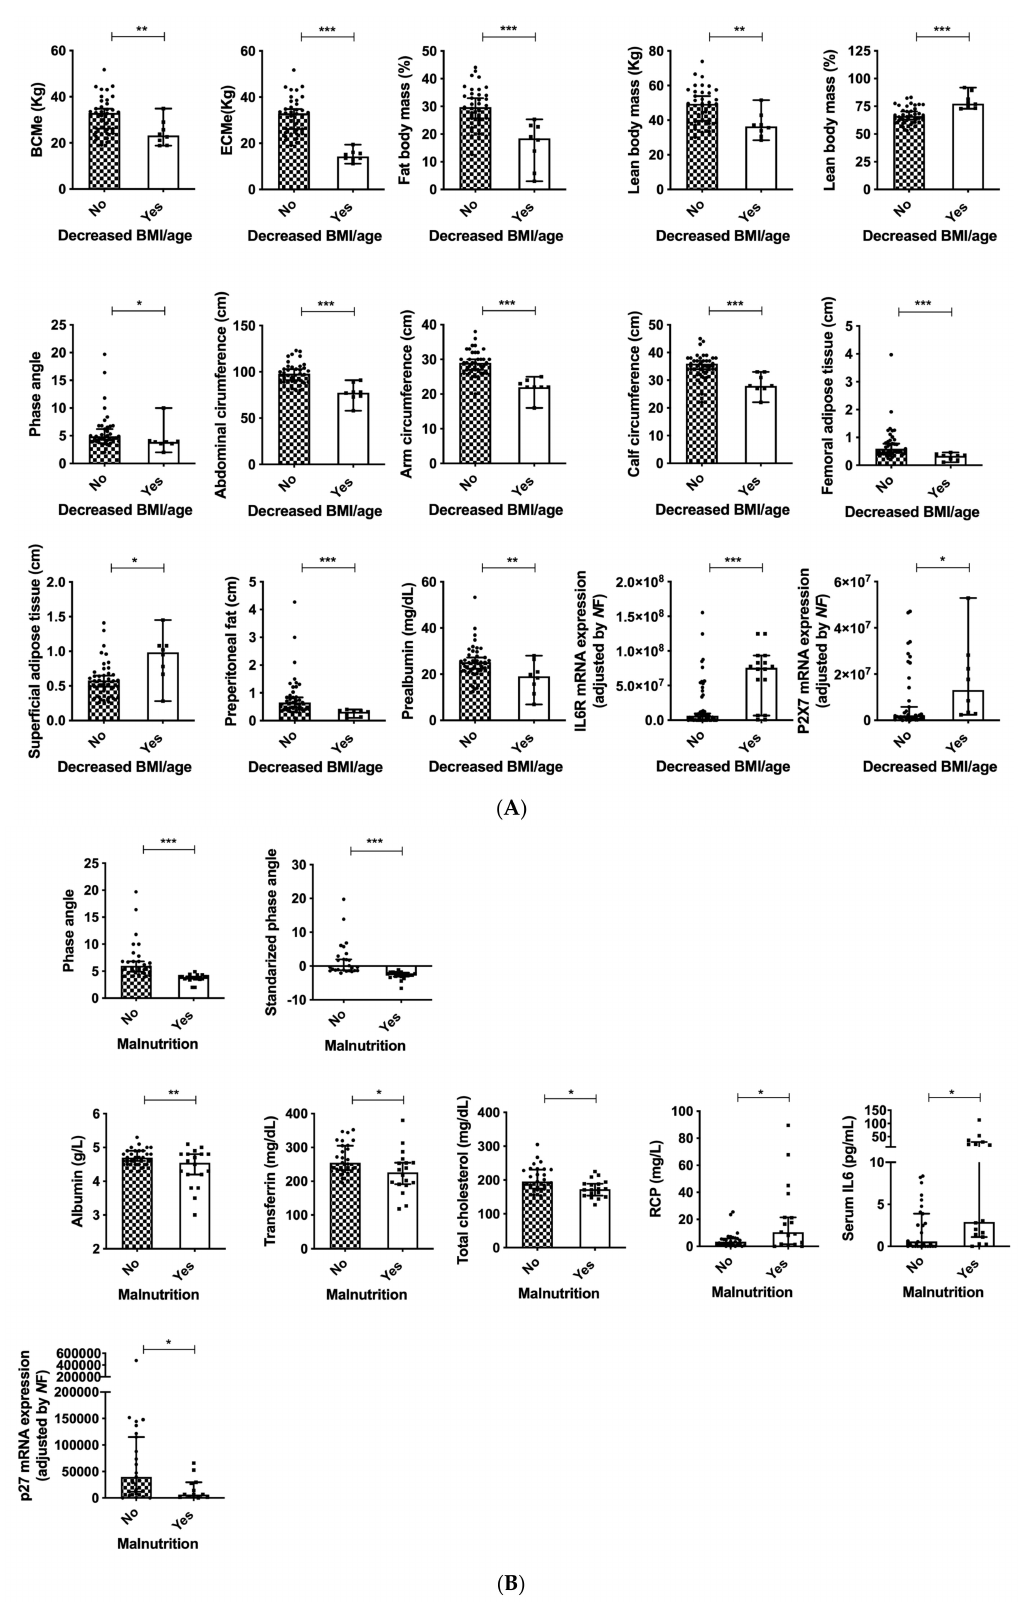
Figure 5. ( A ) Clinical and molecular associations in patients with decreased BMI (adjusted by age) and head and neck cancers; ( B ) Clinical associations in patients with head and neck cancers and malnutrition. Legend: *: p < 0.05; **: p < 0.01; *** p <